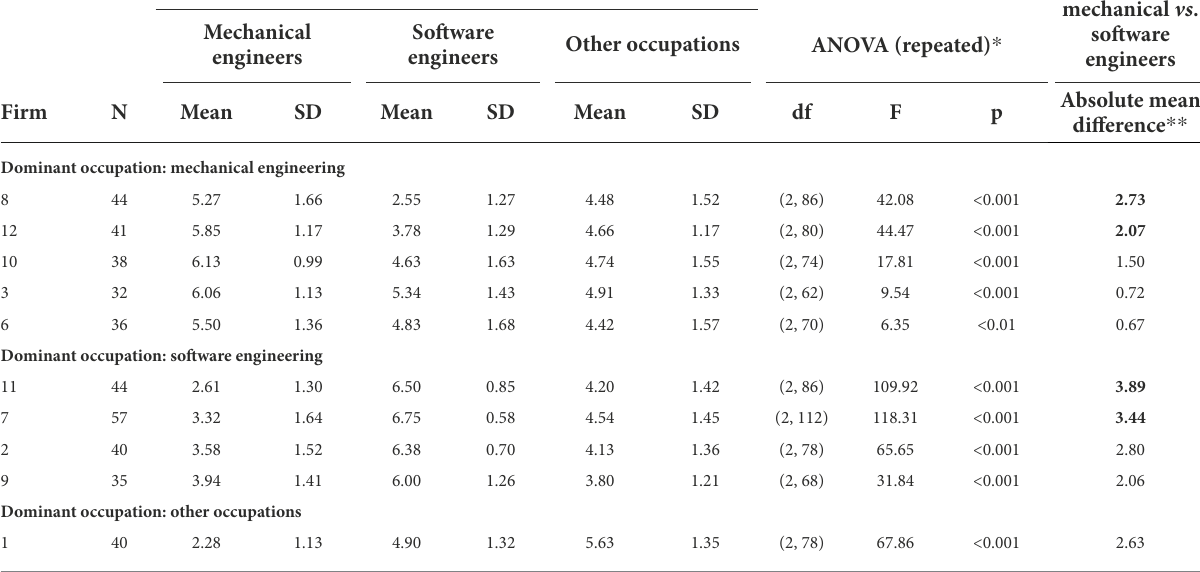
TABLE 1 Results of firm occupation analysis (pre-study). “Mainly employed occupation” Contrast